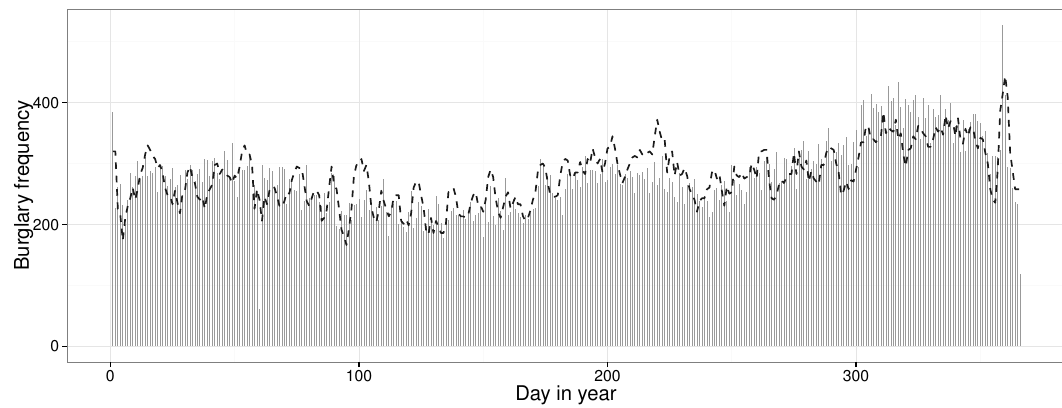
Figure 5. Aoristic distribution of all burglaries and attempted burglaries with a day in the year resolution between 2010 and 2014 with the baseline shown as a dashed line. A rolling window mean of four days was applied to the baseline to increase readability.